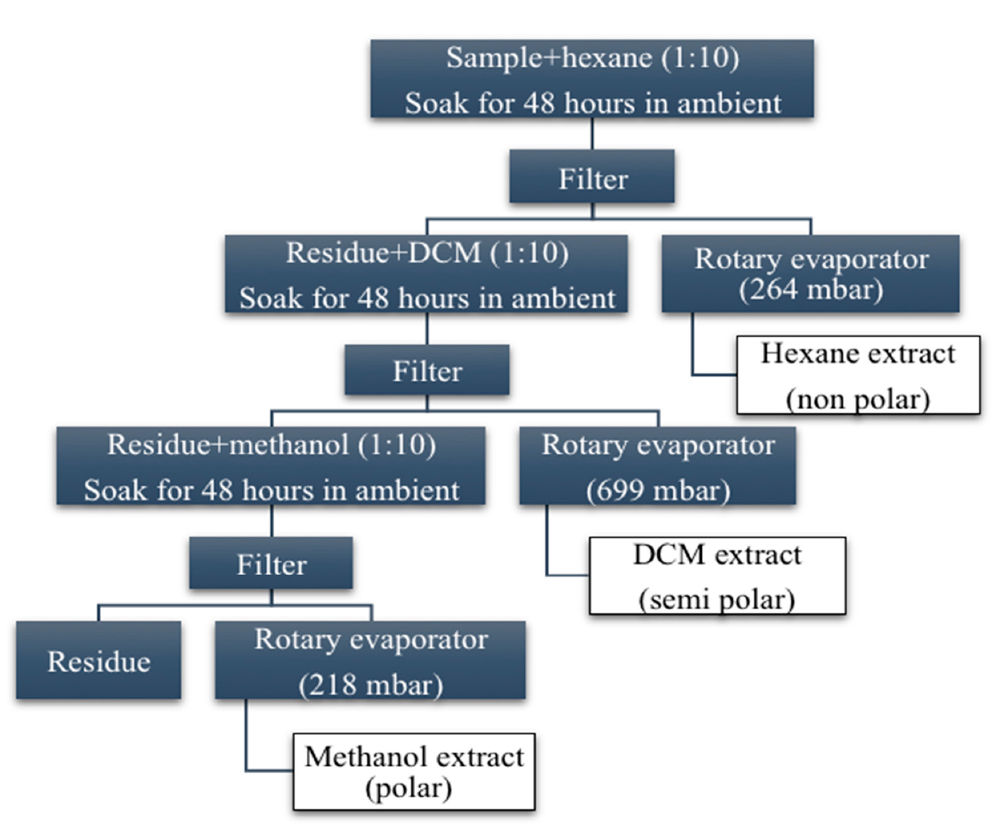
Figure 1. Sequential extraction procedure of V. amygdalina.